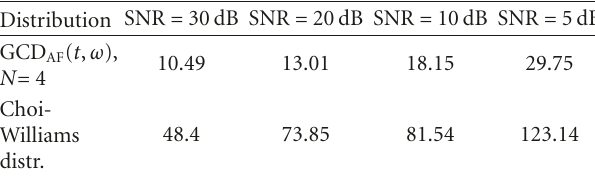
Table 3: MSE of the IF estimation in the presense of